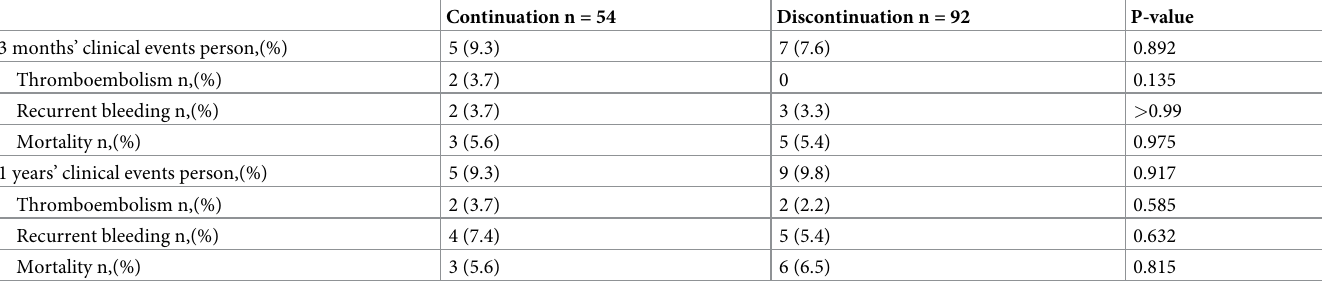
Table 3. Three-months’ and one years’ clinical outcomes of patients during follow